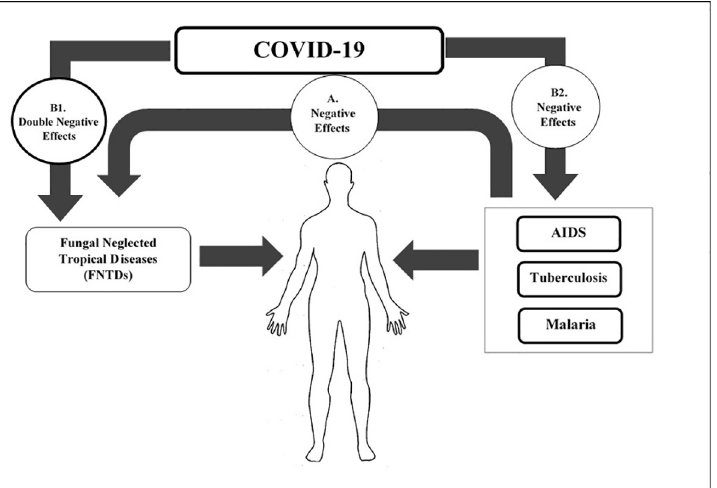
Fig 1. Proposed negative effects. (A) Negative effects of AIDS, malaria, and TB on FNTDs: In endemic areas, people are at risk for AIDS, TB, malaria, and FNTDs. But for reasons such as lower diagnostic focus and inadequate allocated budgets and longer common periods, FNTDs have not received the attention they need, despite their high prevalence. (B1) Negative effects of COVID-19 on FNTDs: On the other hand, with the global prevalence of COVID-19, with the high potential for morbidity and mortality, all the focus of healthcare is on that. Therefore, FNTDs will have other negative effects due to not receiving diagnostic and control requirements, and because they have previously been negatively affected by other diseases such as AIDS, TB, etc., the addition of COVID-19 will cause them to have double negative effects . So with the current situation, it is not unreasonable to call them “Re-Neglected Fungal Tropical Diseases.” (B2) Negative effects of COVID-19 on AIDS, malaria, and TB. COVID-19, Coronavirus Disease 2019; FNTD, fungal neglected tropical disease; TB,